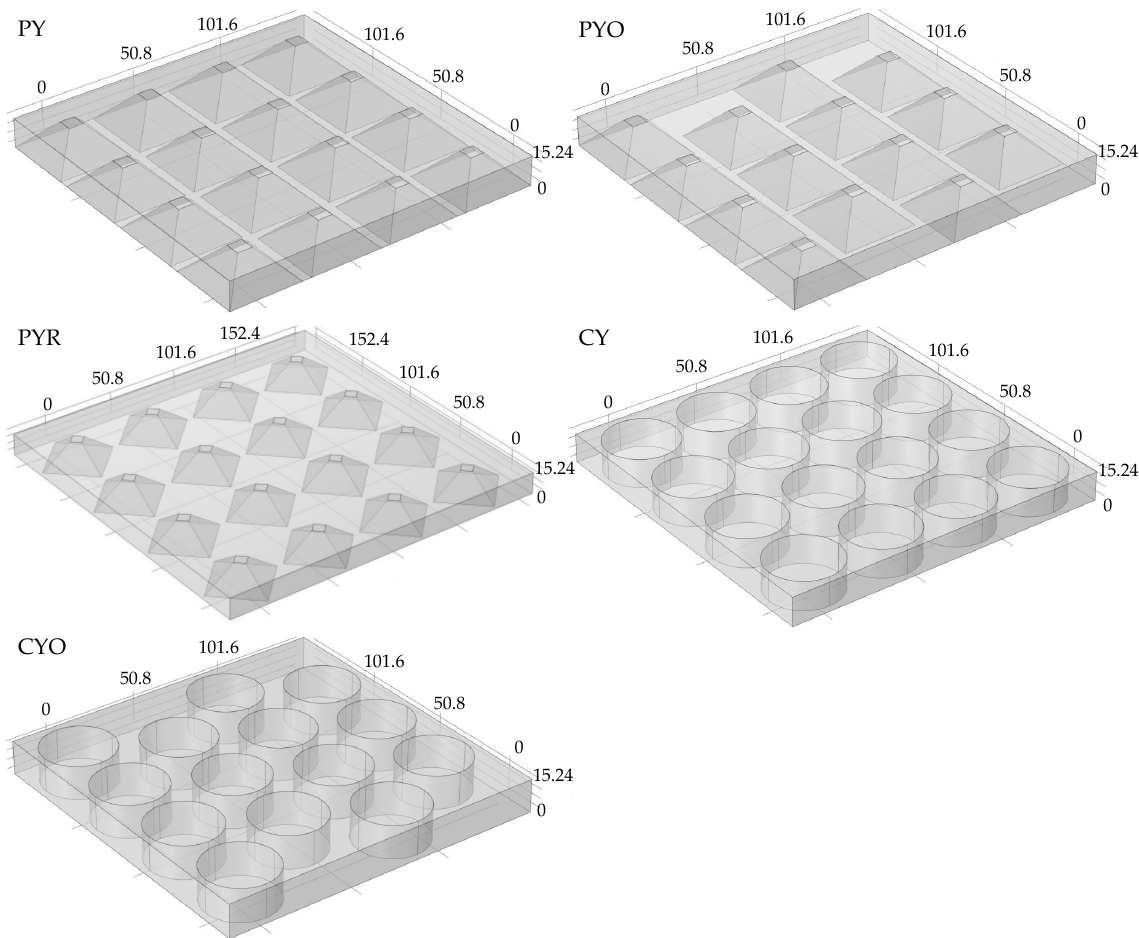
Figure 4. PCM–air heat exchanger designs: PY—pyramidical, PYO—pyramidical with offset, PYR— pyramidical rotated, CY—cylindrical, and CYO—cylindrical with offset. All dimensions are in mm. Table 2. Geometric characteristics of the PCM–air heat exchanger